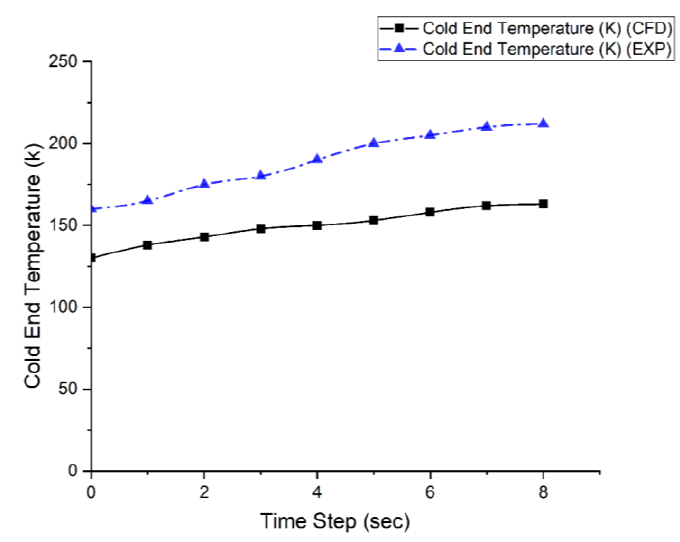
Figure 12. Comparison of heat load and cooling energy of DIPTR for case 1.